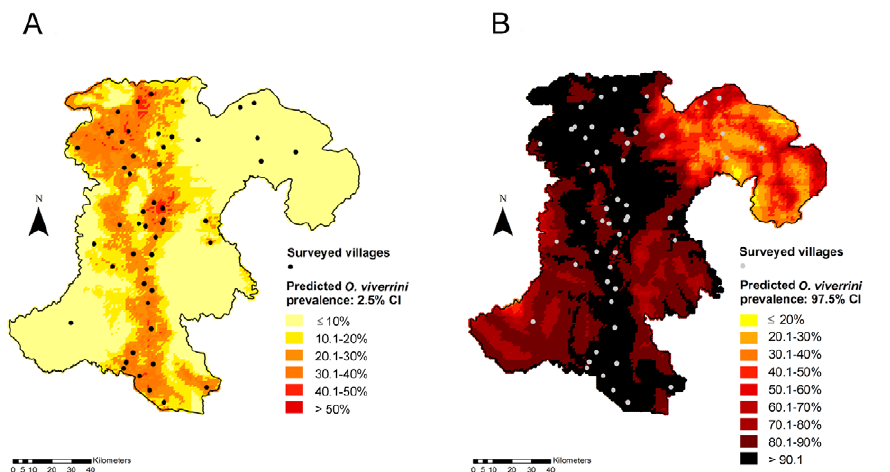
Figure 4. Lower (a) and upper estimates (b) of the predicted prevalence of O.viverrini infection in Champasack province, southern Lao PDR. The lower and upper estimates pertain to the 2.5% and 97.5% confidence interval (CI), respectively.